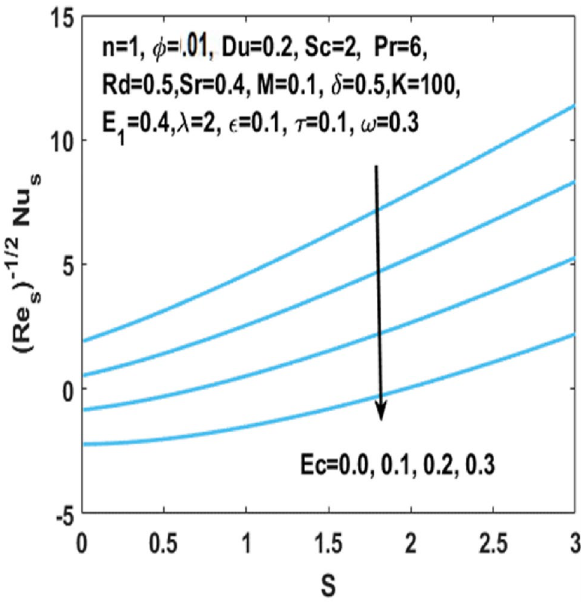
Figure 12. Impact of Ec on Nusselt number w.r.t S .